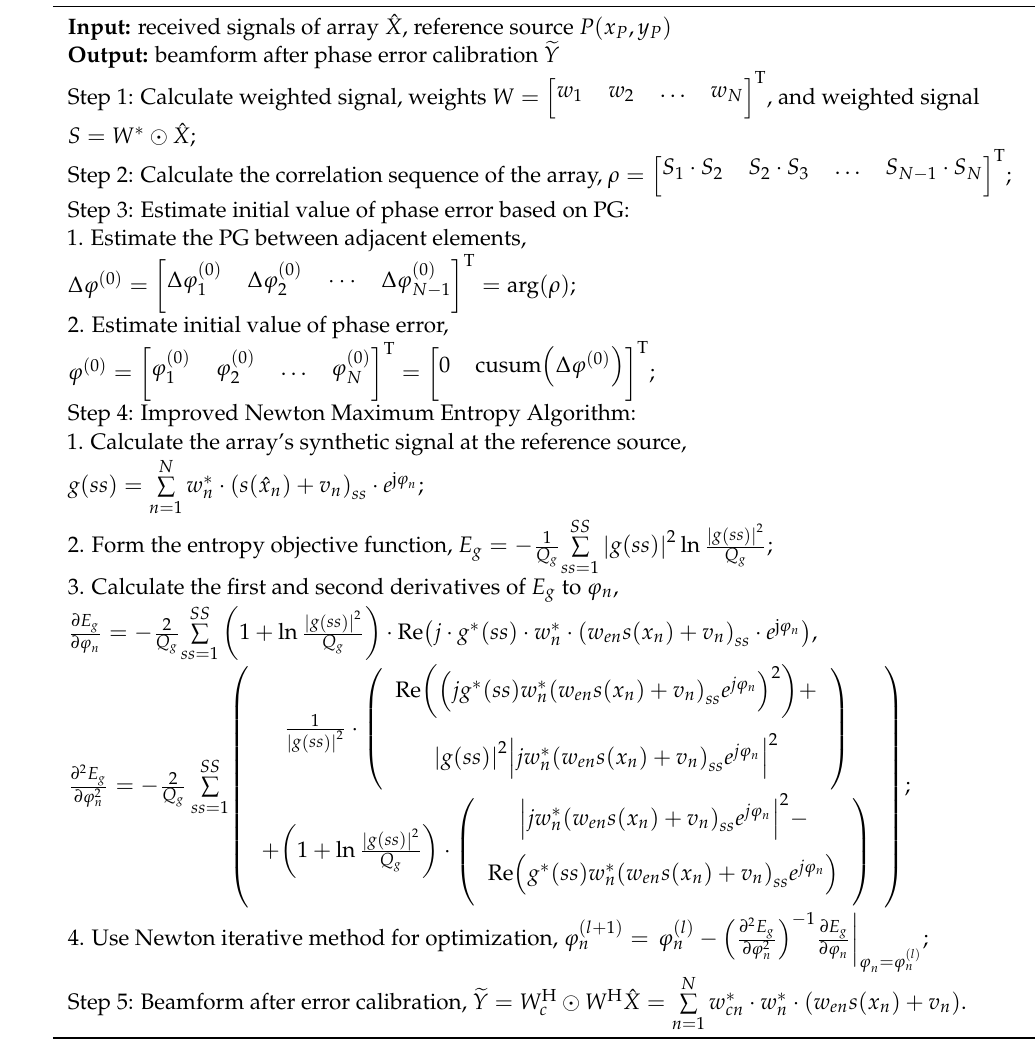
Algorithm 1 The IN-ME phase error compensation algorithm based on reference